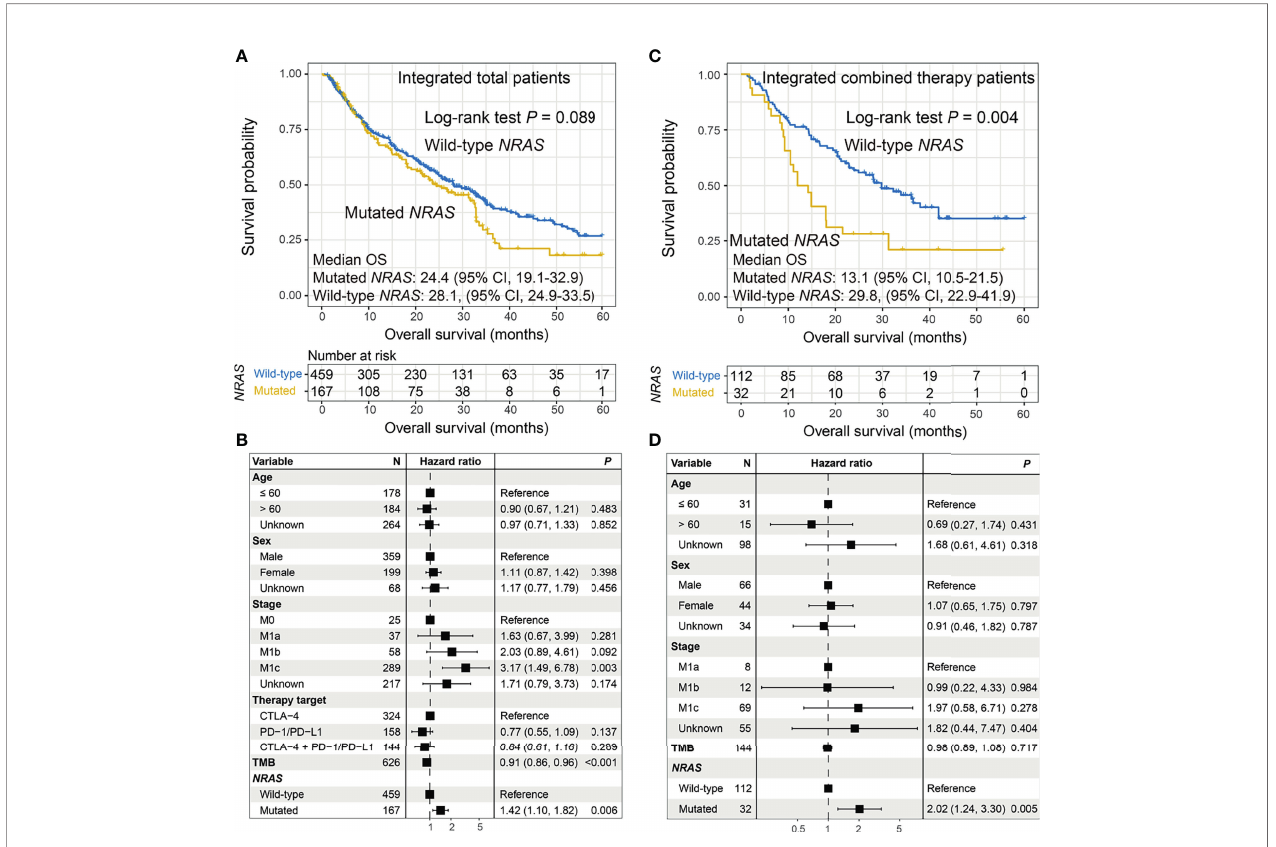
FIGURE 3 | Association between NRAS mutations and immune checkpoint inhibitor (ICI) survival. (A) Overall survival (OS) curves strati fi ed by NRAS mutational status and (B) forest plot representation of the connection of NRAS mutations with OS outcome in the aggregated melanoma cohort. (C) OS curves strati fi ed by NRAS mutational status and (D) forest plot representation of the association of NRAS mutations with ICI outcome in patients who received combined